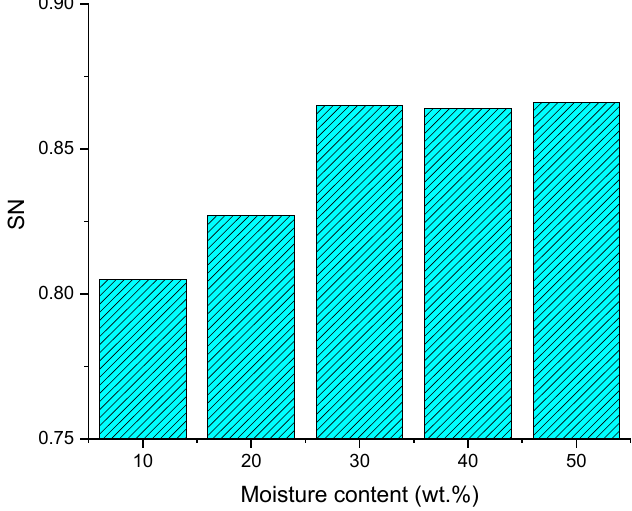
Figure 5. E ff ect of pyrolysis oil moisture content on Figure 5. Effect of pyrolysis oil moisture content on SN.